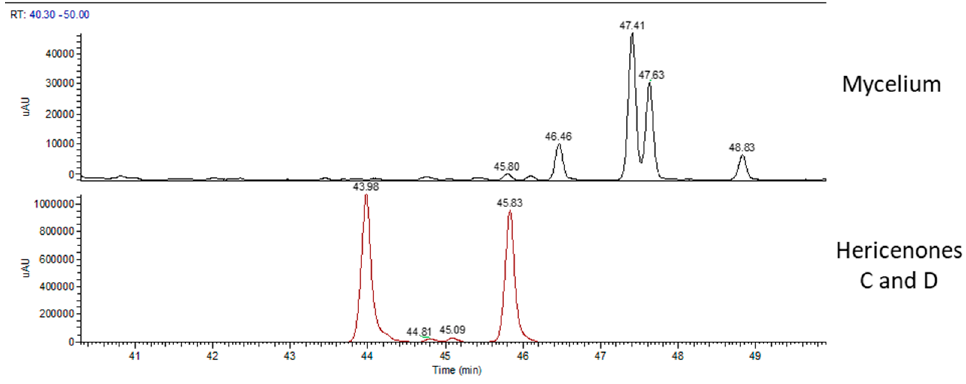
Figure 2. Mass spectrum (MS) traces of mycelium (top) and erinacine A molecule standard (bottom).